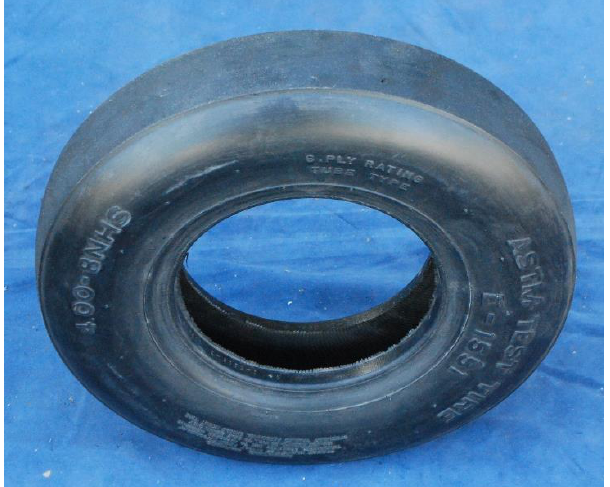
Figure 5. ASTM E-1551 tire.